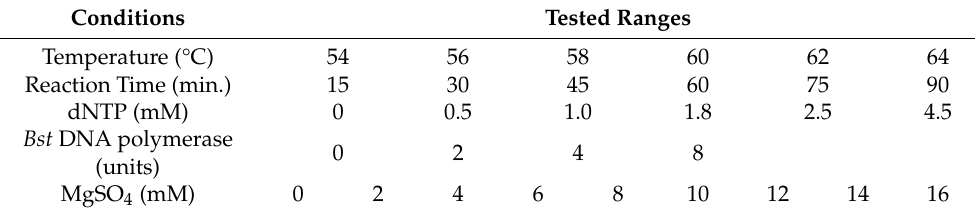
Table 2. Conditions and tested ranges of each factor for optimizing LAMP.